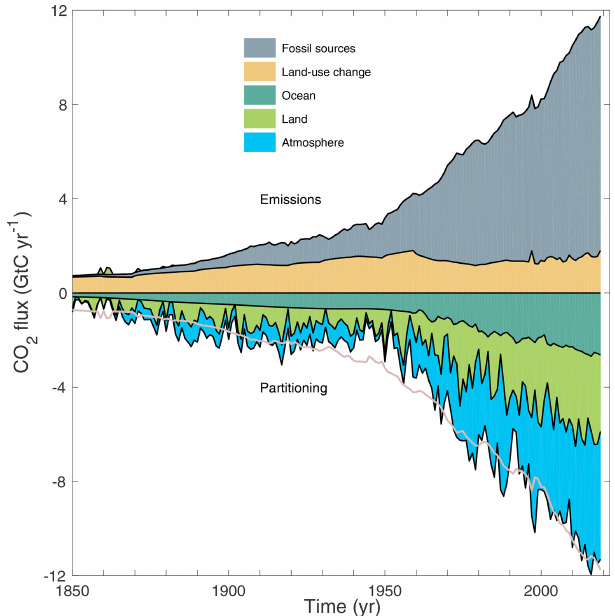
Figure 3. Combined components of the global carbon budget il- lustrated in Fig. 2 as a function of time, for fossil CO 2 emissions ( E FOS , including a small sink from cement carbonation; grey) and emissions from land-use change ( E LUC ; brown), as well as their partitioning among the atmosphere ( G ATM ; blue), ocean ( S OCEAN ; turquoise), and land ( S LAND ; green). The partitioning is based on nearly independent estimates from observations (for G ATM ) and from process model ensembles constrained by data (for S OCEAN and S LAND ) and does not exactly add up to the sum of the emis- sions, resulting in a budget imbalance which is represented by the difference between the bottom pink line (reflecting total emissions) and the sum of the ocean, land, and atmosphere. All time series are in GtCyr − 1 . G ATM and S OCEAN prior to 1959 are based on differ- ent methods. E FOS values are primarily from Gilfillan et al. (2020), with uncertainty of about ± 5% ( ± 1 σ ). E LUC values are from two bookkeeping models (Table 2) with uncertainties of about ± 50%. G ATM prior to 1959 is from Joos and Spahni (2008) with uncer- tainties equivalent to about ± 0.1–0.15GtCyr − 1 , and from Dlu- gokencky and Tans (2020) from 1959 with uncertainties of about ± 0.2GtCyr − 1 . S OCEAN prior to 1959 is averaged from Khatiwala et al. (2013) and DeVries (2014) with uncertainty of about ± 30%, and from a multi-model mean (Table 4) from 1959 with uncertain- ties of about ± 0.5GtCyr − 1 . S LAND is a multi-model mean (Ta- ble 4) with uncertainties of about ± 0.9GtCyr − 1 . See the text for more details of each component and their